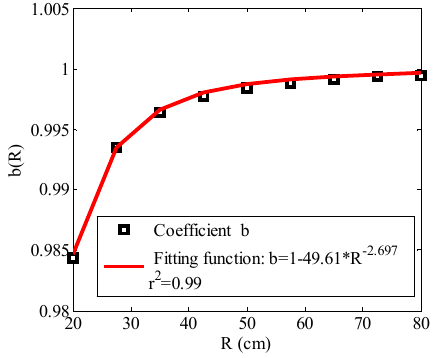
Figure 8. Variation of the coefficient k as a function of radius.